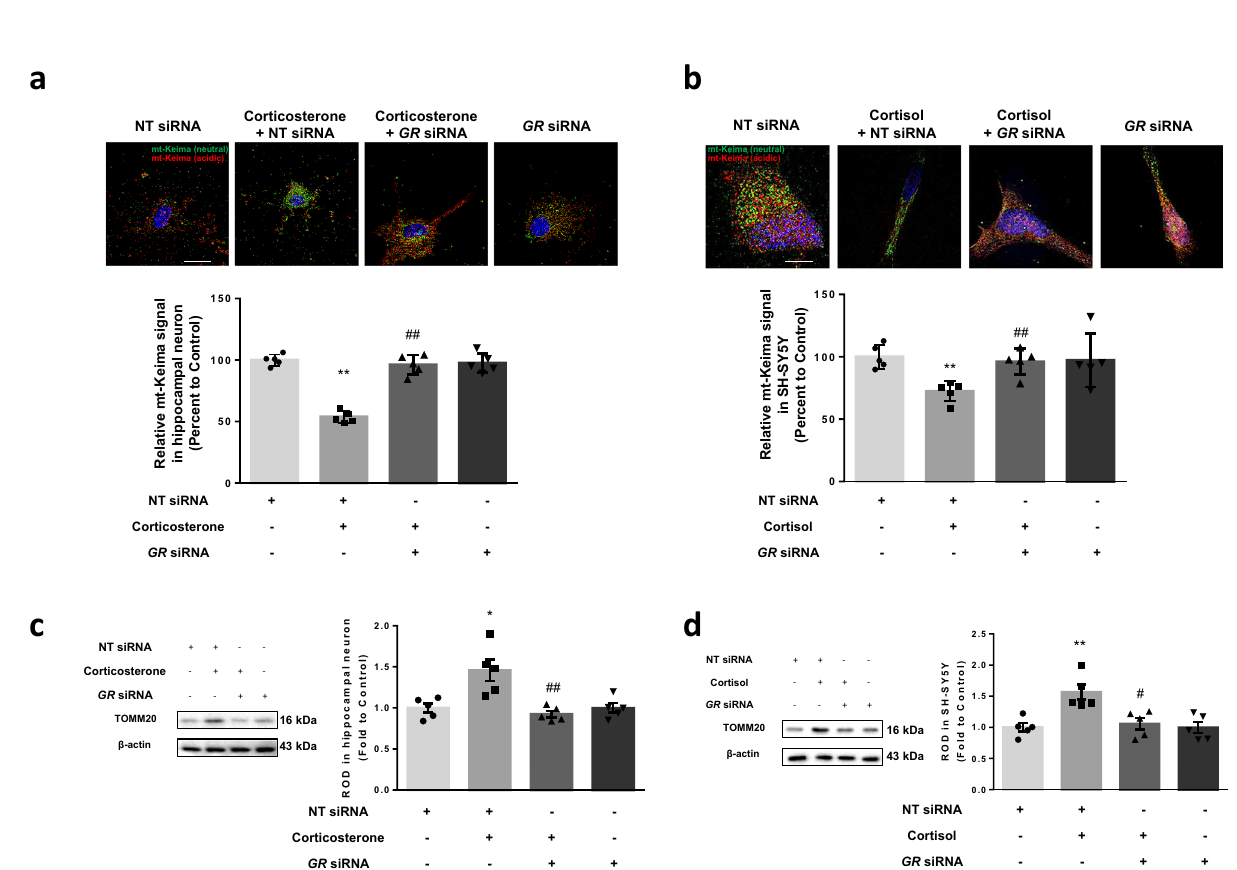
Fig. 4 NIX upregulation recovers glucocorticoid-induced mitochondrial dysfunction. a , b Hippocampal neurons were pretreated with phorbol 12-myristate 13-acetate (PMA, 10 nM) for 30 min prior to corticosterone for 24 h. SH-SY5Y cells were transfected with pcDNA3.1/c-eGFP or pcDNA3.1/ NIX-c-eGFP vector for 24 h prior to cortisol treatment for 24 h. The level of mtROS was measured via MitoSOX staining with luminometer. n = 5. c – d Hippocampal neurons were pretreated with PMA (10 nM) for 30 min prior to corticosterone for 48 h. SH-SY5Y cells were transfected with pcDNA3.1/ c-eGFP or pcDNA3.1/NIX-c-eGFP vector for 24 h prior to cortisol treatment for 48 h. Mitochondrial membrane potential was measured via tetramethylrhodamine ethyl ester (TMRE) staining with luminometer. n = 5. e – h Both hippocampal neurons and SH-SY5Y cells were pretreated with PMA for 30 min before corticosterone and cortisol treatment for 48 h, respectively. Oxygen consumption rate (OCR) changes under mitochondrial stress test were measured by using Seahorse SF24 Extracelluar Flux analyzer where oligomycin, carbonyl cyanide-4-(tri fl uoromethoxy)phenylhydrazone (FCCP), and antimycin A/rotenone mixture were treated. n = 5. Statistics of basal respiration, maximal respiration, ATP production, and proton leak were also presented. i – k Hippocampal neurons were pretreated with PMA for 30 min prior to corticosterone for 48 h. i Synaptophysin and PSD95 were detected by western blot. Loading control is β -actin. n = 5. j After stimulation with depolarization buffer, cells were incubated with synaptotagmin-1 antibody. Synaptophysin (green) was used to visualize synapse and synaptotagmin-1 (red) was used for measuring uptake of synaptic vesicles. Scale bars, 20 μ m (magni fi cation, ×1000). n = 5. k Conditioned hippocampal neurons were stained with FM4-64 dye and stimulated with high K + buffer for destaining. Time- lapse imaging was performed over 180 sec at 1 sec intervals with an Eclipse Ts2 TM fl uorescence microscopy. n = 5. All blots and immuno fl uorescence images are representative. n = 5 from independent experiments with two technical replicates each. Quantitative data are presented as a mean ± S.E.M. The representative images were acquired by SRRF imaging system. Two-sided two-way ANOVA was conducted. *,** indicates p < 0.05, p < 0.01 versus control, respectively. # , ## indicates p < 0.05, p < 0.01 versus corticosterone in hippocampal neurons and cortisol in SH-SY5Y, respectively. Data are provided as a Source data fi le.